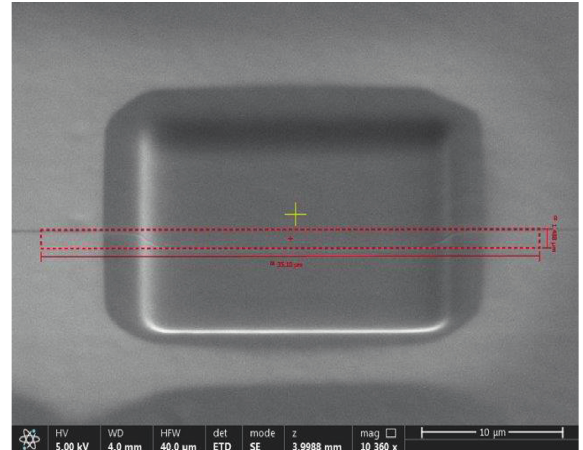
Figure 2: Depth measurement of a milled rectangle using the milled scribe line